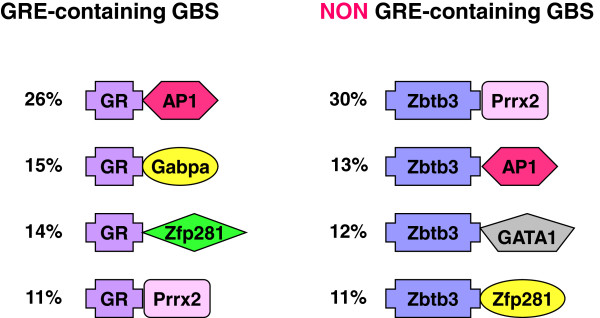
The most frequent motif-combinations within the GBS. Specific combinations of motifs for transcription factor binding were observed, with differences in occurrence and frequency between the GBS with and without a GRE. TF: transcription factor.